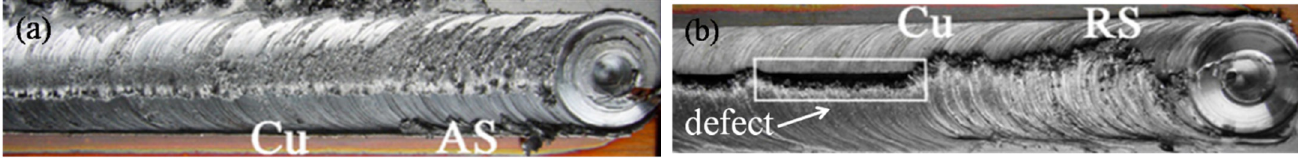
Figure 7. Surface morphologies of the FSW Al–Cu joints: ( a ) Cu plate fixed at AS; ( b ) Cu plate fixed at RS (adapted from [13], with permission from Elsevier, 2011).